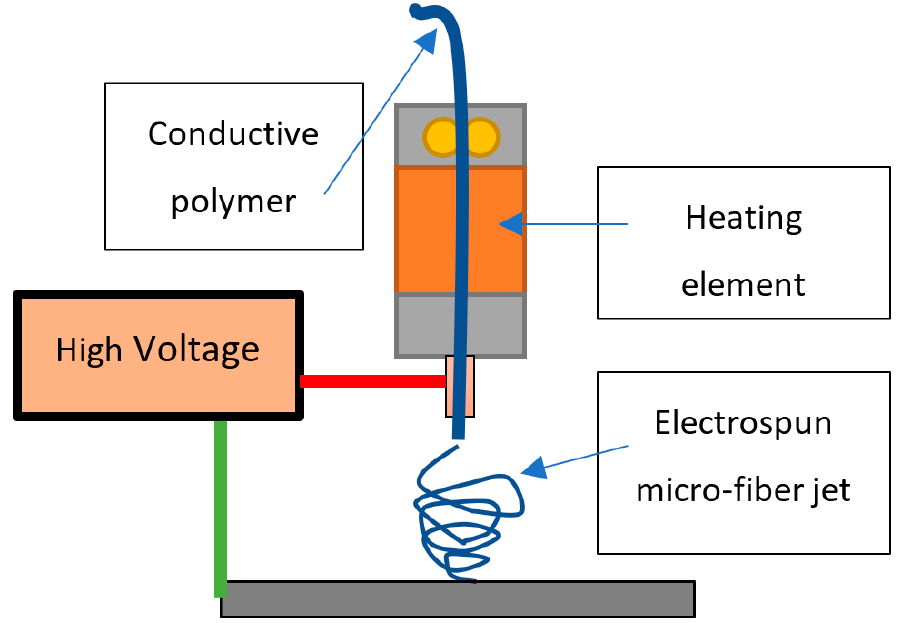
Figure 1. Melt electrospinning system setup with a high-voltage power supply and heating element coil.